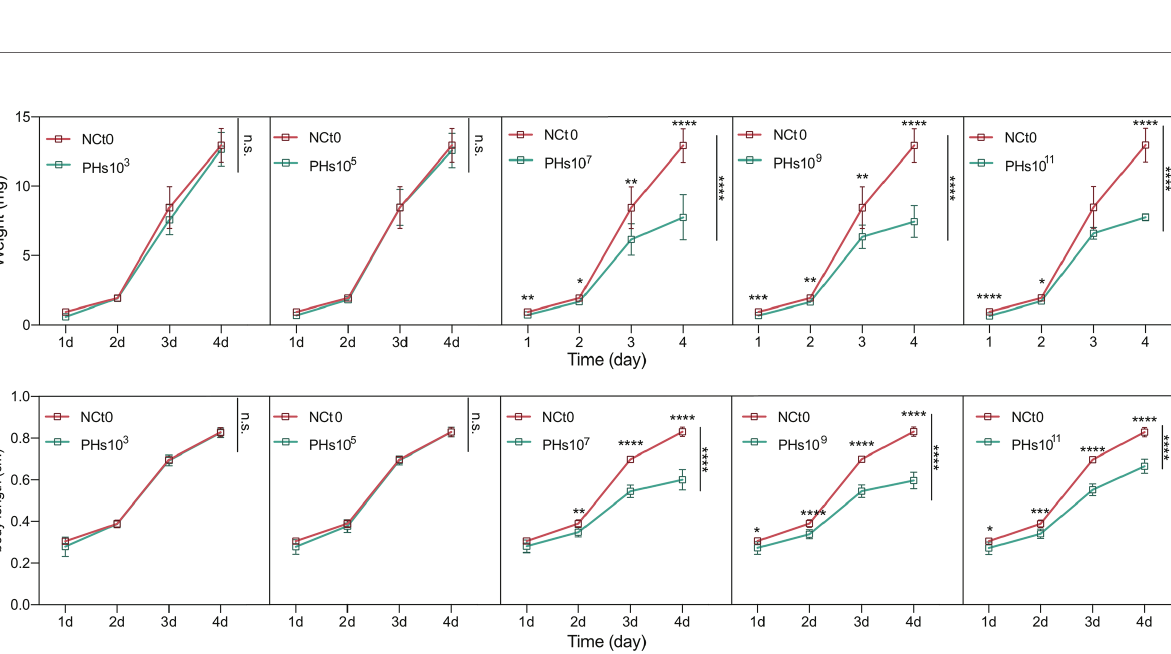
FIGURE 3 | Changes in the development of house fl y larvae treated with different dilutions of E. hormaechei ‘ s phage. (A) The body weights of the house fl y larvae changed signi fi cantly over time in the different treatments (B) The body lengths of the house fl y larvae changed signi fi cantly over time in the different treatments. NCt0, PHs10 3 , PHs10 5 , PHs10 7 , PHs10 9 and PHs10 11 represent house fl y larval samples treated with sterile water and sterile water containing 10 3 ,10 5 ,10 7 ,10 9 and 10 11 PFU/mL phage. Data are shown as the means ± SEM. Repeated measures ANOVA was followed by Sidak correction for multiple comparisons. * P < 0.05, ** P < 0.01, *** P < 0.001, **** P < 0.0001. n.s., no signi fi